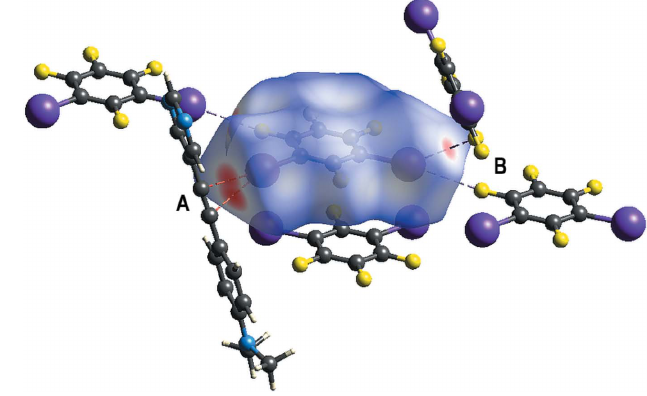
with pairs of 13DIFB molecules shown between APEP molecules.